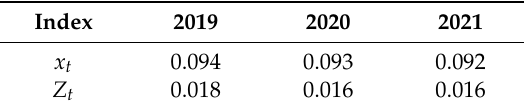
Table 5. Predictions of T HS ( x t ) and the intervention impact ( Z t ) from 2019 to 2021 in the Xin’an River